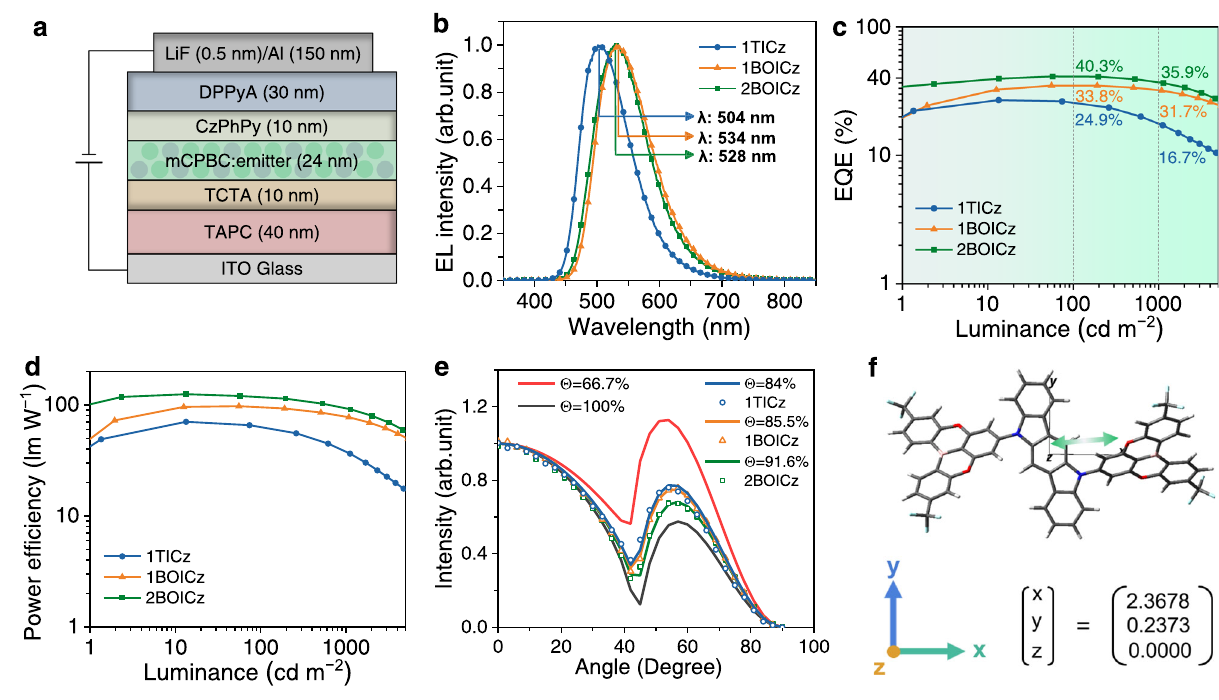
Fig. 3 | Device structure and performance of OLEDs. a Architectures of the devices. b Normalized EL spectra under 1000cdm − 2 . c EQE versus luminance characteristics. d Power ef fi ciency versus luminance characteristics. e Angle-